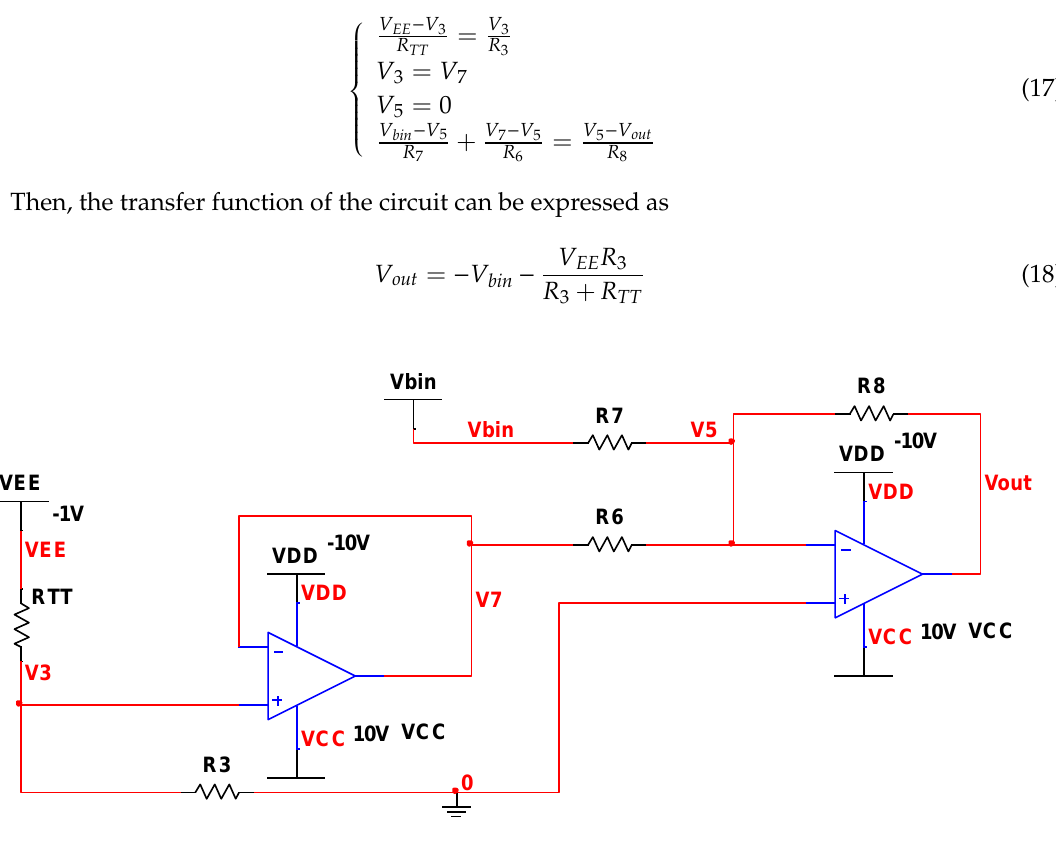
Figure 8. MEMS gyroscope temperature bias compensation circuit.